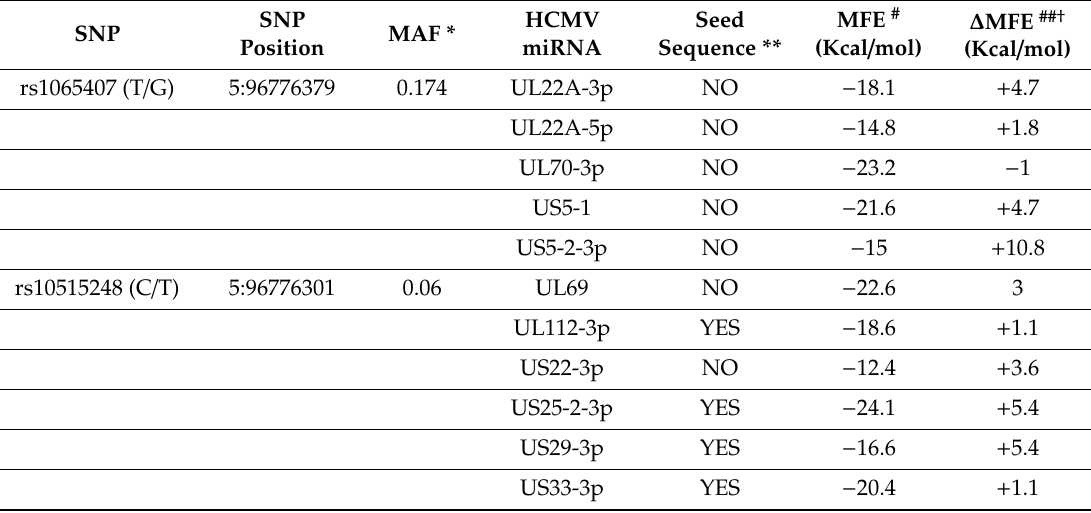
Table 1. HCMV miRNAs targeting the 3 (cid:48) UTR of ERAP1 gene in polymorphic sites in which the alternative allele a ff ects the minimum free energy of hybridization